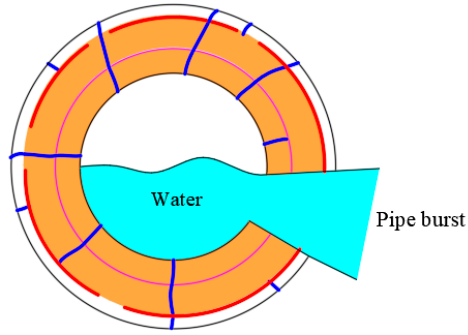
Figure 20. Pipe barrel burst stage.